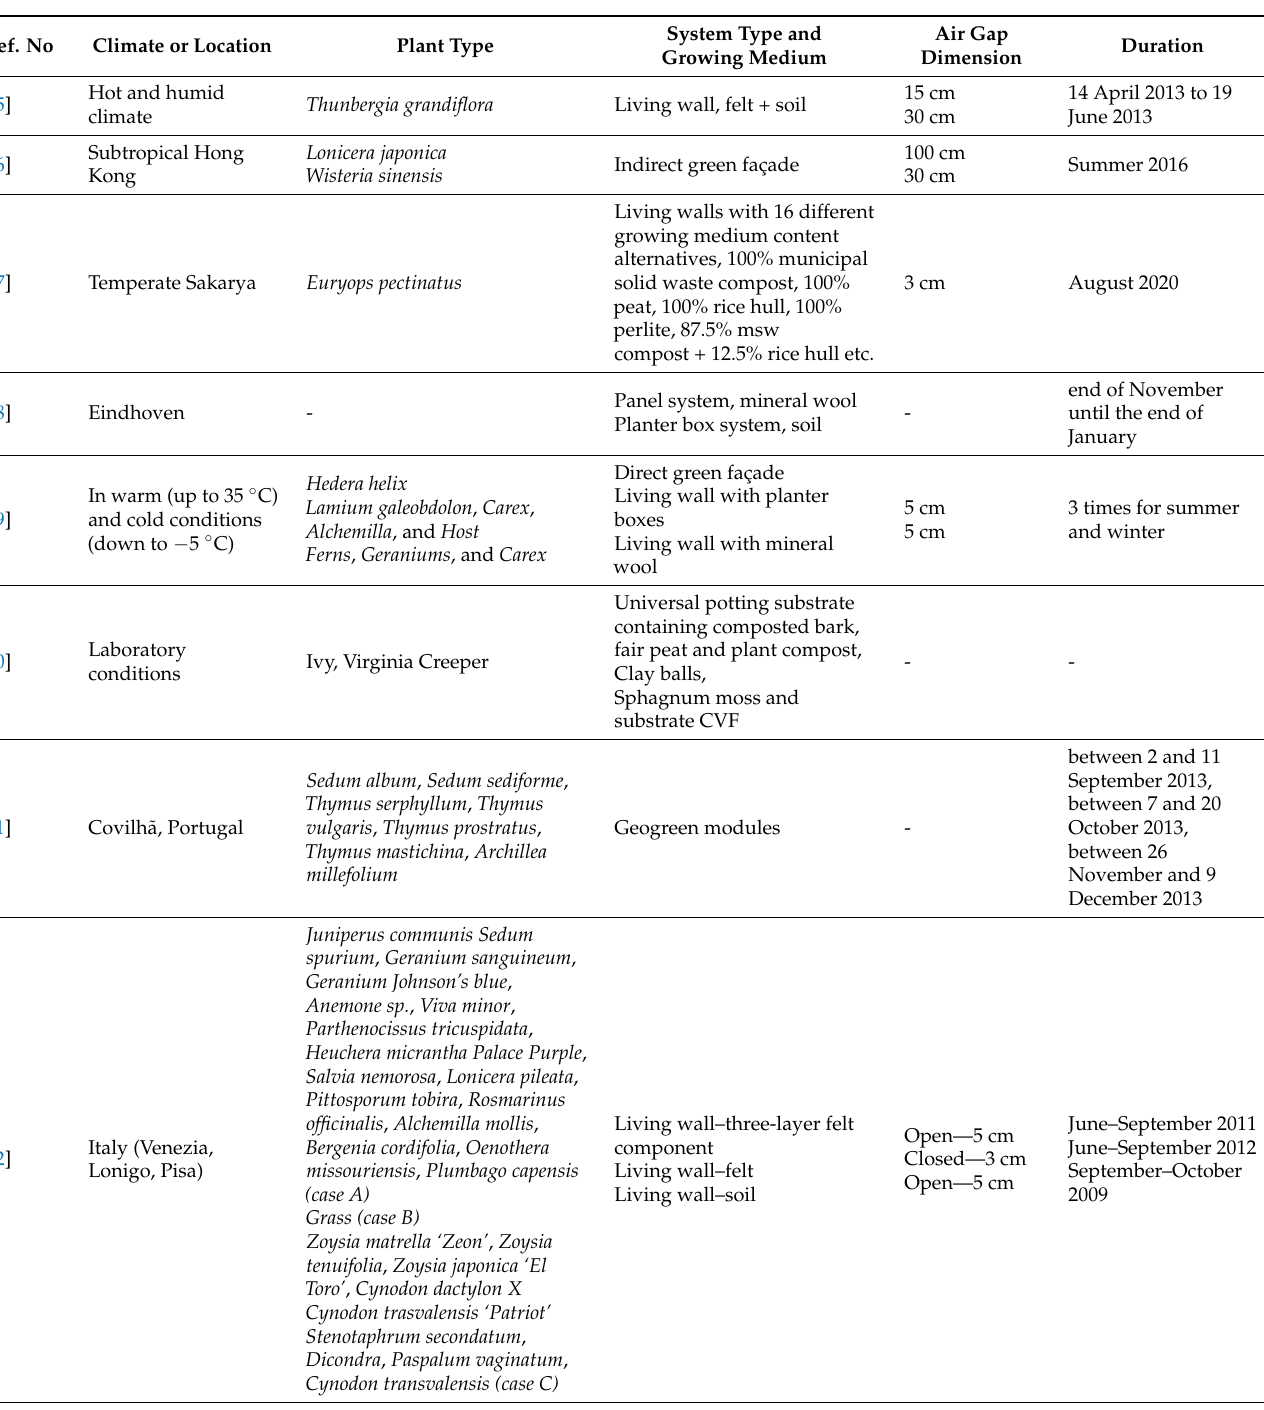
Table 2. The data of different vertical green façade systems of previous simulative and experimental